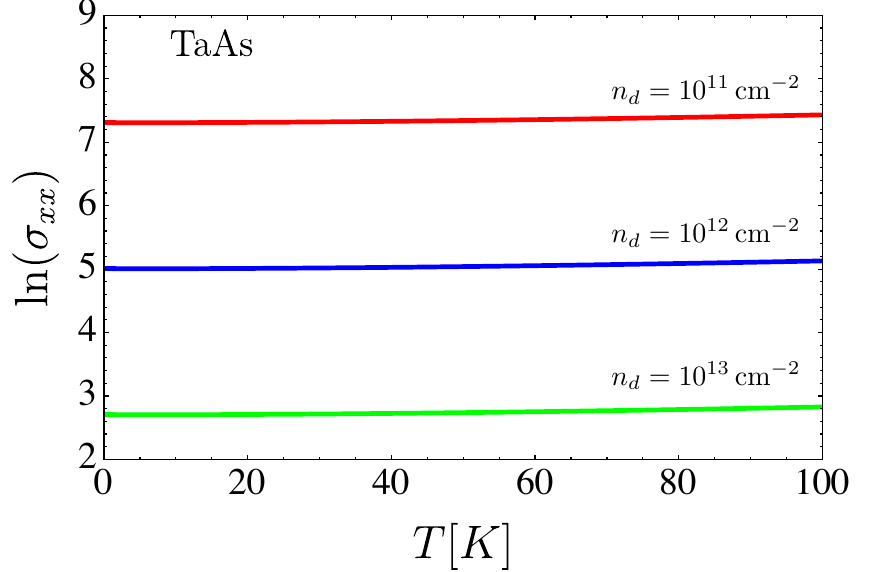
Figure 9. Natural logarithm of the conductivity versus temperature for three different concentrations of dislocations.